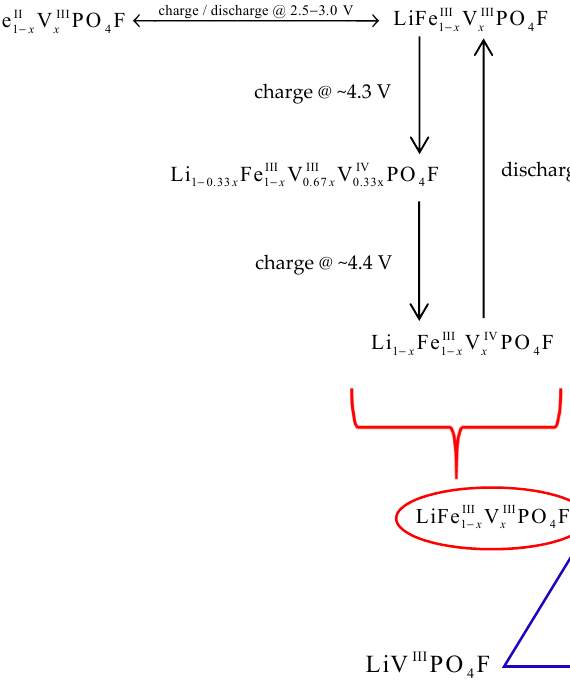
same sweep rate of 0.1 mV s –1 for five cycles in the range of 2.0 − 4.5 V ( a ), 2.0 − 3.6 V ( b ) and 3.0 − 4.5 V